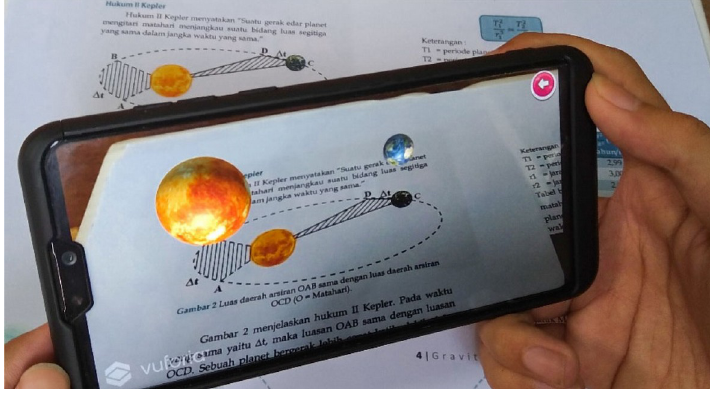
Figure 11. Kepler’s second law 3D object projection